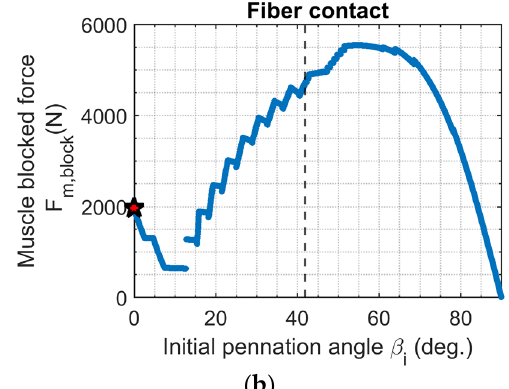
Figure 12. Variation in muscle blocked force at a constant applied pressure of 345 kPa ( 50 psi ) with initial pennation angle for ( a ) pinned boundary condition and ( b ) fiber contact boundary condition. The red star indicates a parallel ( β i = 0 ◦ ) topology, and a dashed vertical line indicates the boundary between fiber contraction-limited (left of the line) and fiber rotation-limited (right of line) topologies.